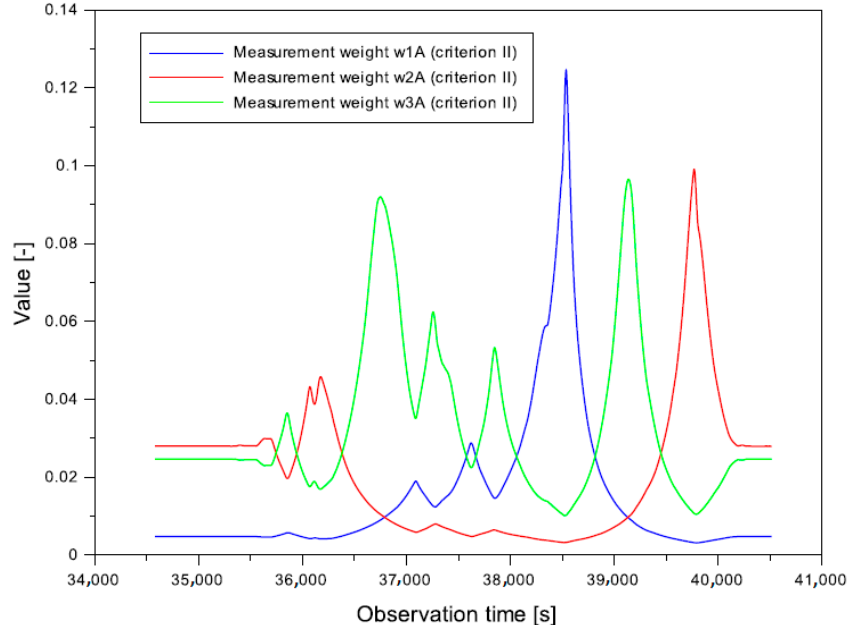
Figure 7. The measurement weights for criterion II.